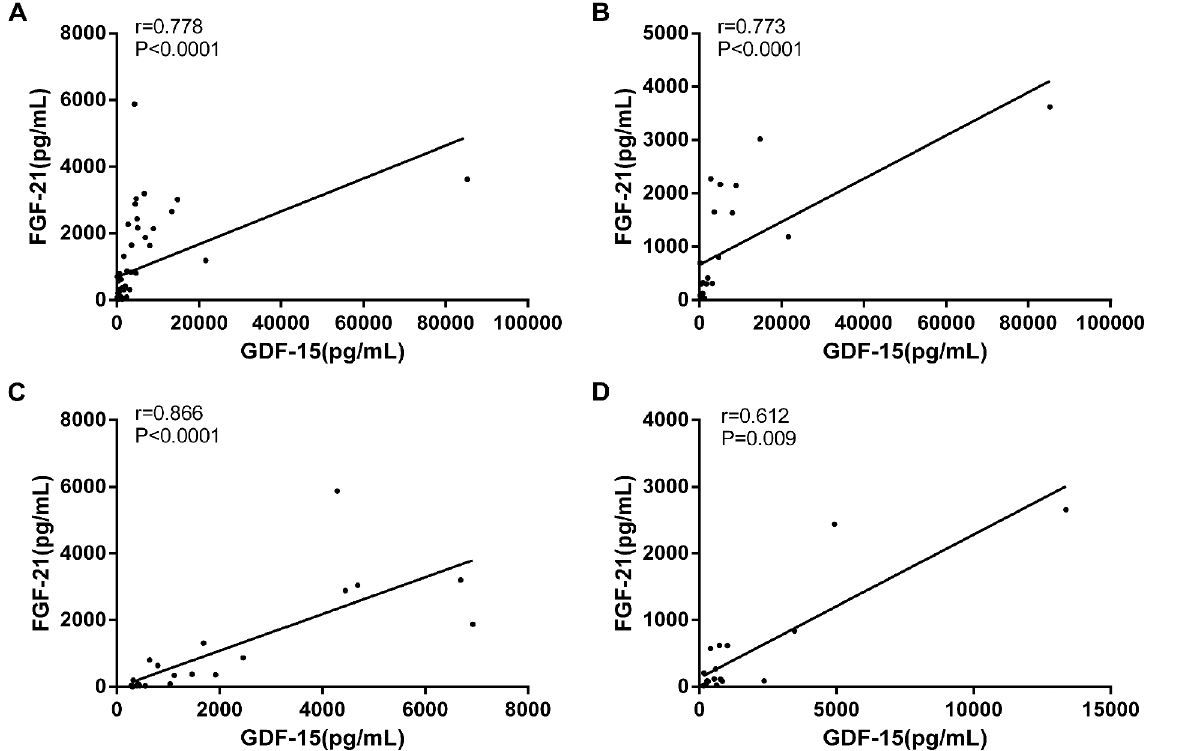
Fig 2. Correlation analysis between GDF-15 and FGF-21. serum levels in samples from all patient groups taken as a whole (A), group 1(B), group 2 (C) and group